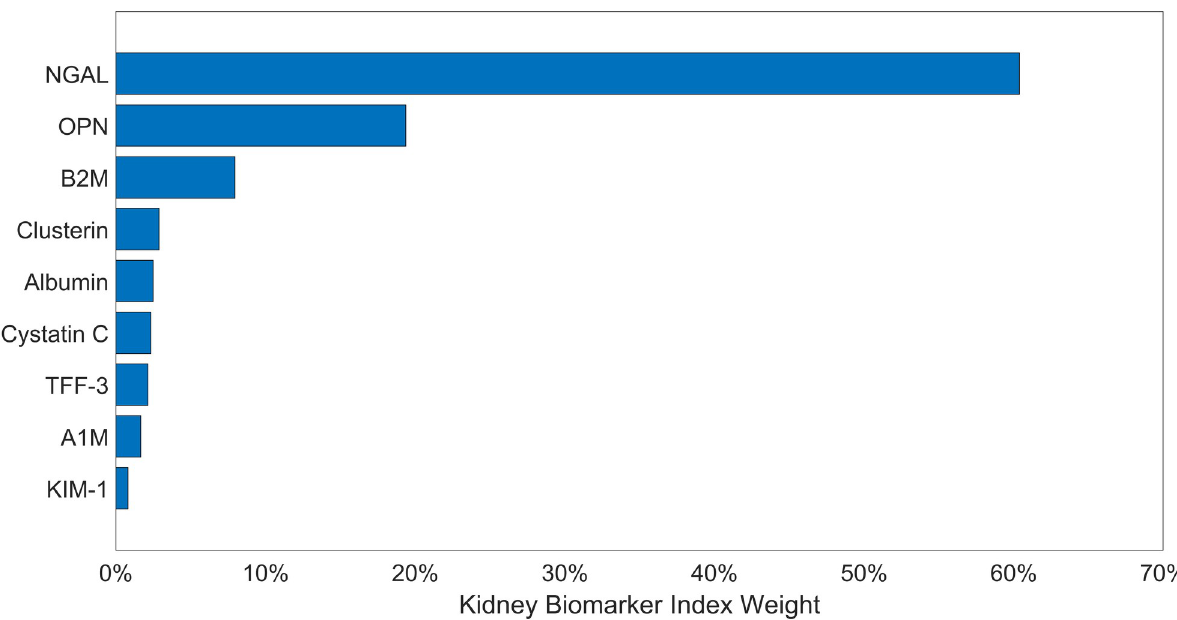
Fig 2. Weights of proteins contributing to the kidney biomarker index estimated for length of gestation. Larger weights indicate greater contribution of the protein to the index.